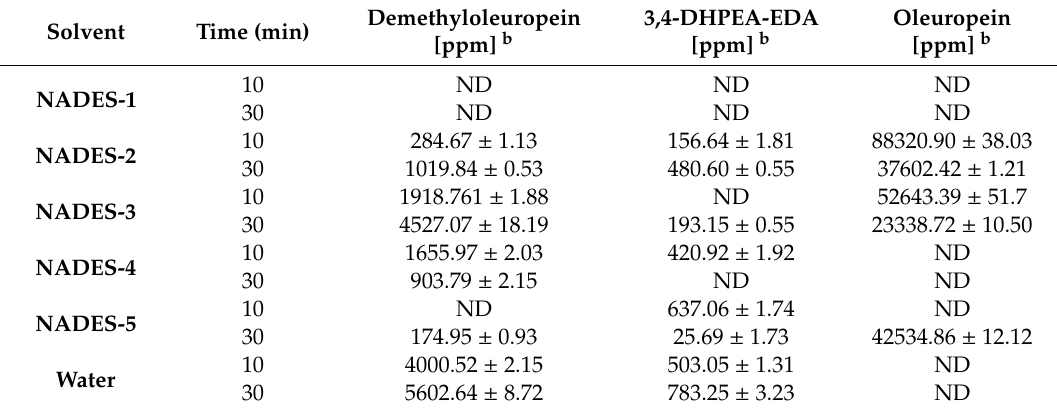
Figure 2. Quantitative analysis of oleuropein in olive leaf extracts carried out by HPLC. Data are expressed as mean ± SD of three independent observations (p < 0.05). Table 4. Content of phenolic compounds in the examined ripe olive extracts (in NADESs or water) from HPLC analysis a